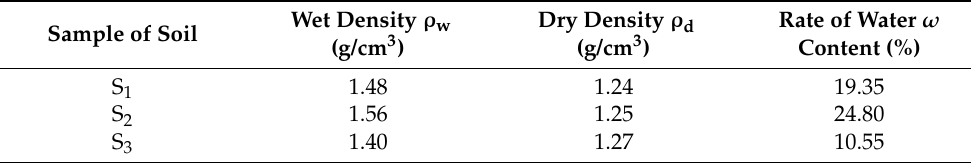
Figure 1. Soil density tests of undisturbed collapsible loess. ( a ) Soil samples. ( b ) Soil specimen cut by cutting ring. ( c ) Dry oven. Table 1. Soil material parameters before compaction.